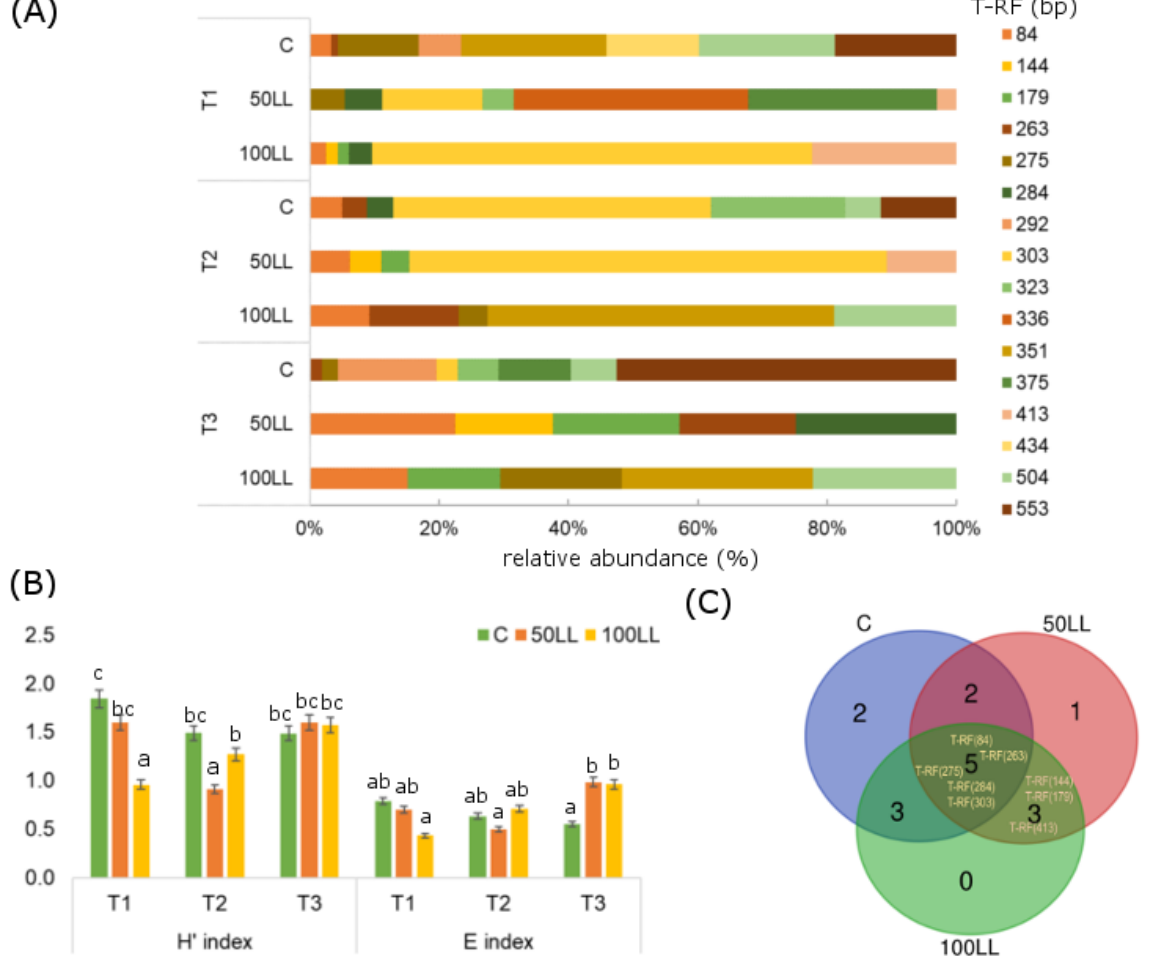
Figure 3. Relative abundance (%) of soil bacteria terminal restriction fragments (T-RFs, bp) after Hae III digestion ( A ); Shannon—H’ and Evenness—E indices ( B ); relationships between bacterial T-RFs presented as Venn diagram ( C ); The same letters presented on ( B ) describe non-significant differences between means assessed by Tukey HSD post-hoc test at p < 0.05.